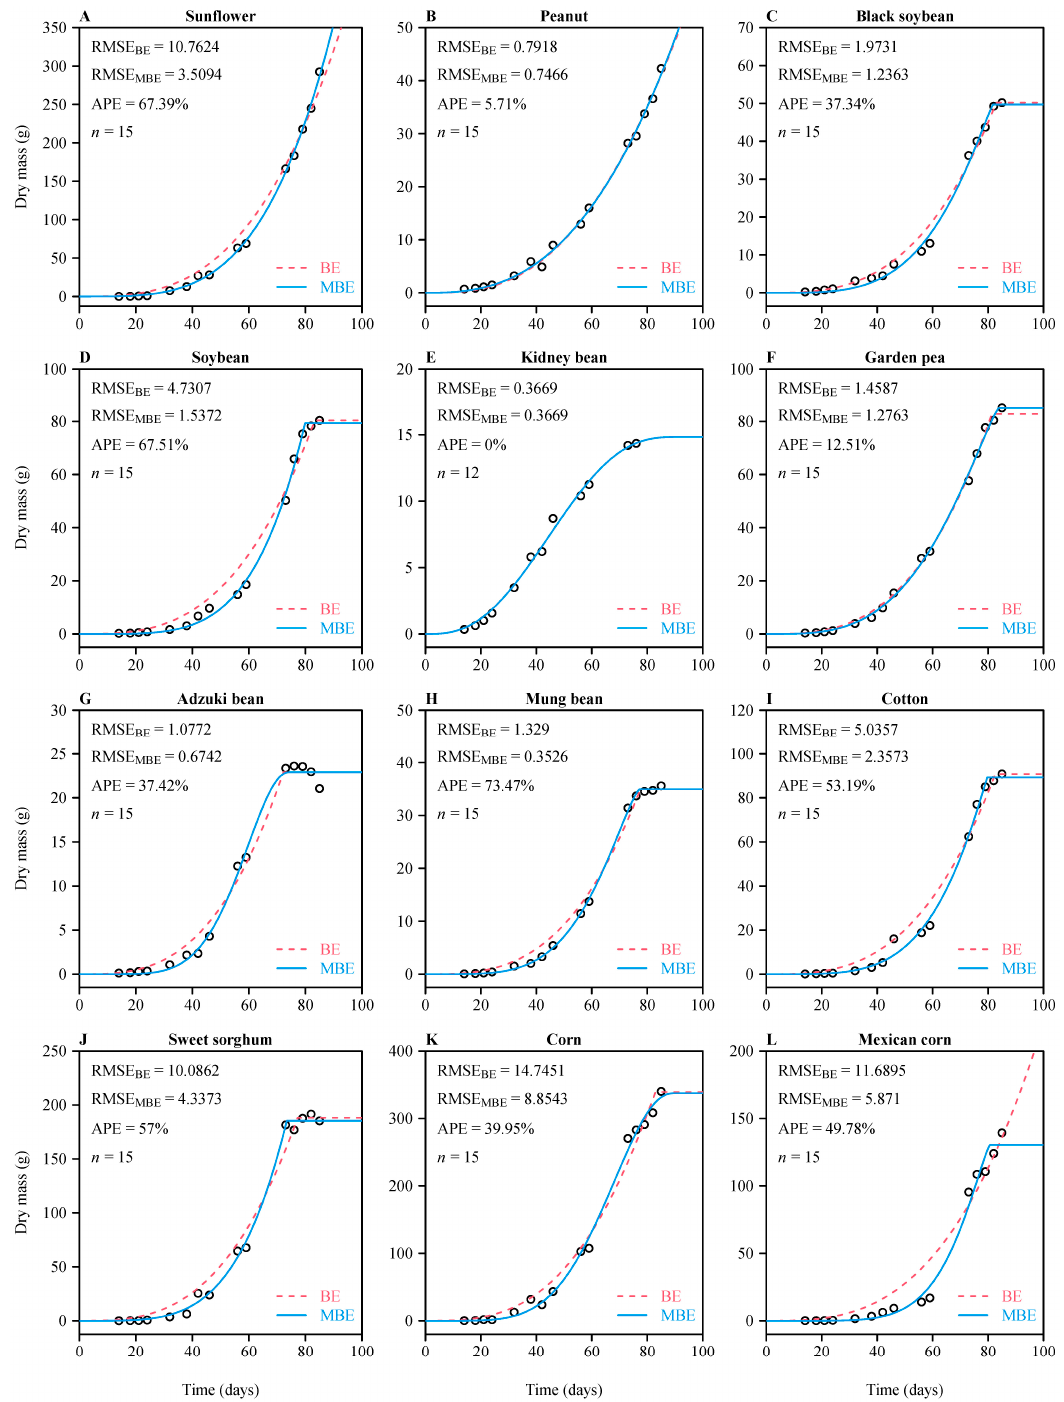
Figure 2. Results of fitting two sigmoid functions (based on the BE and MBE) to the whole-plant dry mass versus time data of 11 crop species (with two cultivars for one crop species). The small open circles represent the observed dry mass at different times after the sowing date; the red dashed curves represent the dry mass values predicted by the BE sigmoid equation; the blue solid curves represent the dry mass values predicted by the MBE sigmoid equation. RMSE represents the root-mean-square error between the observed and predicted y values; APE represents the percentage error of the absolute difference between the two equations’ RMSE values; n represents the sample size. Panels ( A – L ) represent different